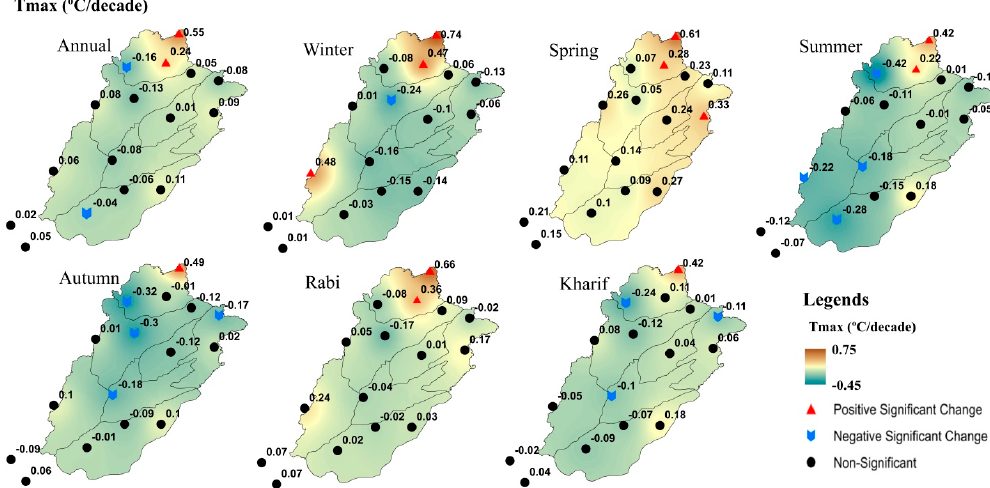
Figure 3. Change per decade and signs of trends at meteorological stations for T max for the year, winter, spring, summer, autumn, Rabi, and Kharif in Punjab for the period 1967–2017.